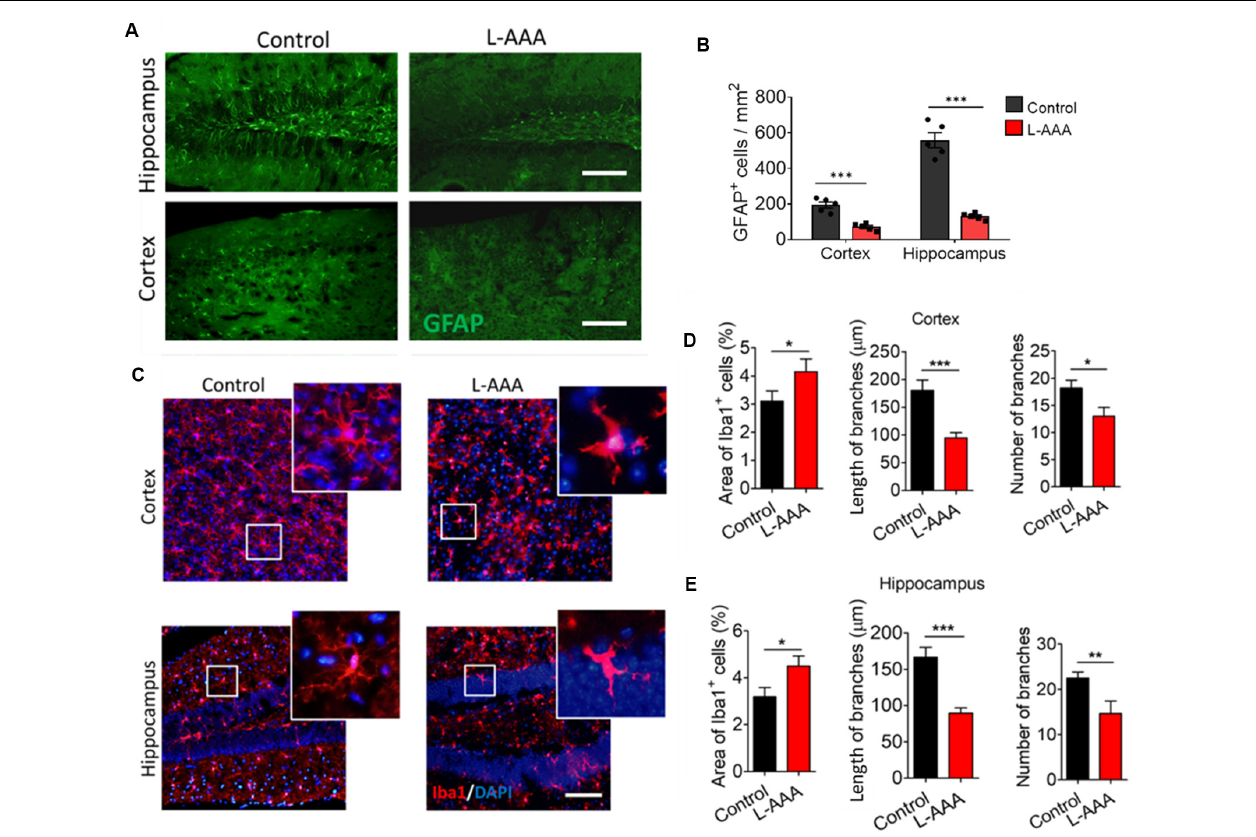
FIGURE 2 | Ablation of astrocytes results in ameboid microglia in mouse hippocampus and cortex. (A) Fluorescence micrographs showing astrocytes in cortex and hippocampus from L-alpha-aminoadipic acid (L-AAA)-treated or control mice. Astrocytes were labeled by GFAP (green). Scale bar, 100 µ m. (B) Quantification of GFAP + cells in the hippocampus and cortex. (C) Fluorescence micrographs showing microglia in the cortex and hippocampus from L-AAA-treated or control mice. Microglia were labeled by Iba1 (red) and nuclei by DAPI (blue). The zoomed insets highlight differences in microglial morphology in the hippocampus of L-AAA-treated mice or control mice. Scale bar, 50 µ m. (D) Percentage of Iba1 + cells, and length and number of branches in the cortex from L-AAA-treated or control mice. (E) Percentage of Iba1 + cells, and length and number (J) of branches in the hippocampus from L-AAA-treated or control mice. Data are presented as mean ± SEM ( n = 12). * P < 0.05, ** P < 0.01 and *** P < 0.005 (unpaired t